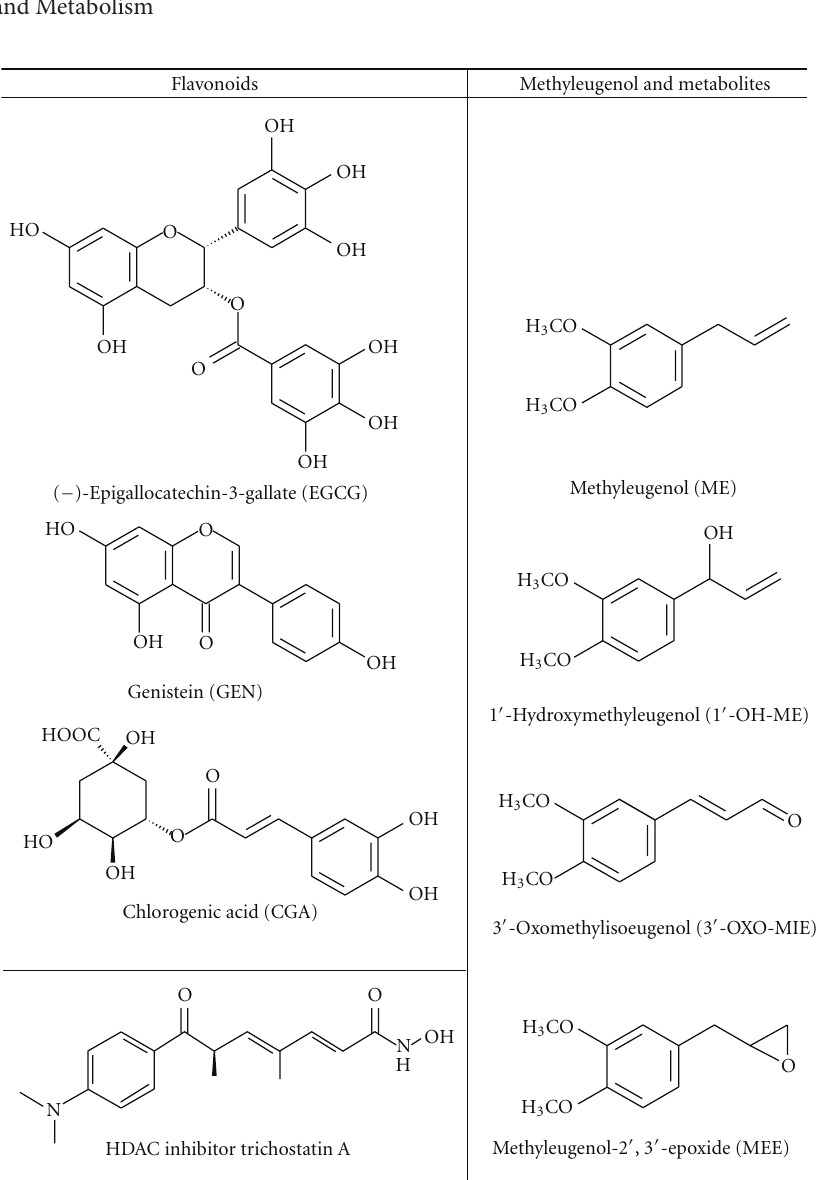
Figure 1: Food-derived polyphenols of different classes and structure of methyleugenol and selected oxidative metabolites.